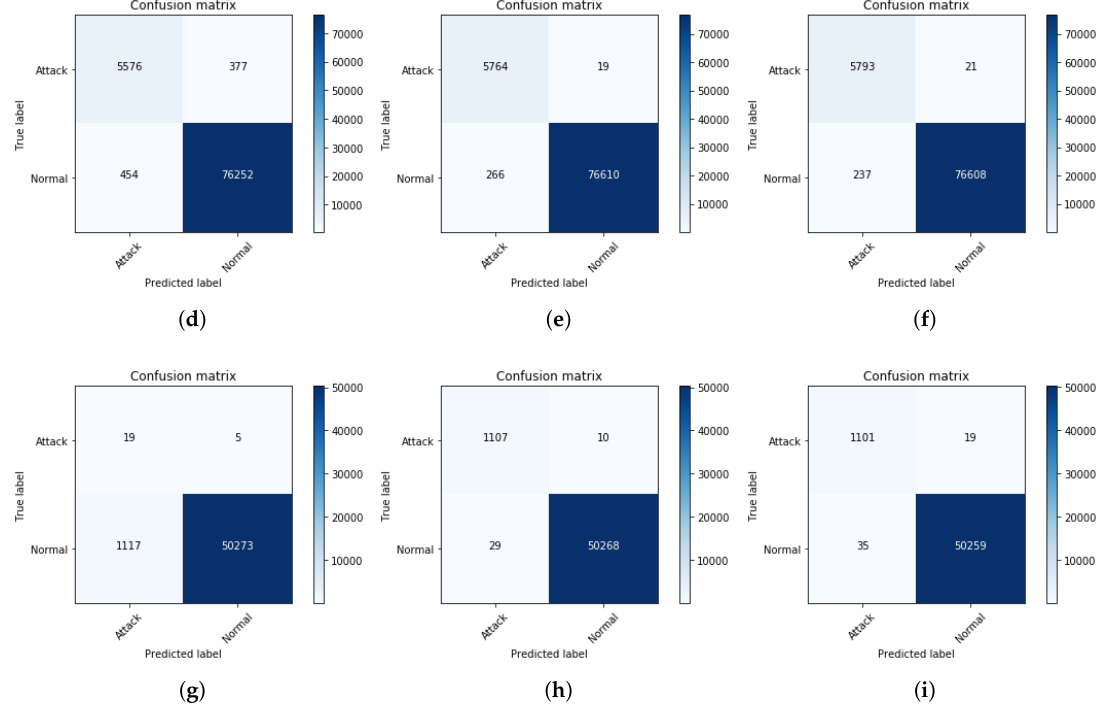
Figure 14. Confusion matrix results of three approach models RNN, LSTM, and GRU on ISCX selected feature subset. ( a – c ) on Saturday, ( d – f ) on Sunday, ( g – i ) on Monday.